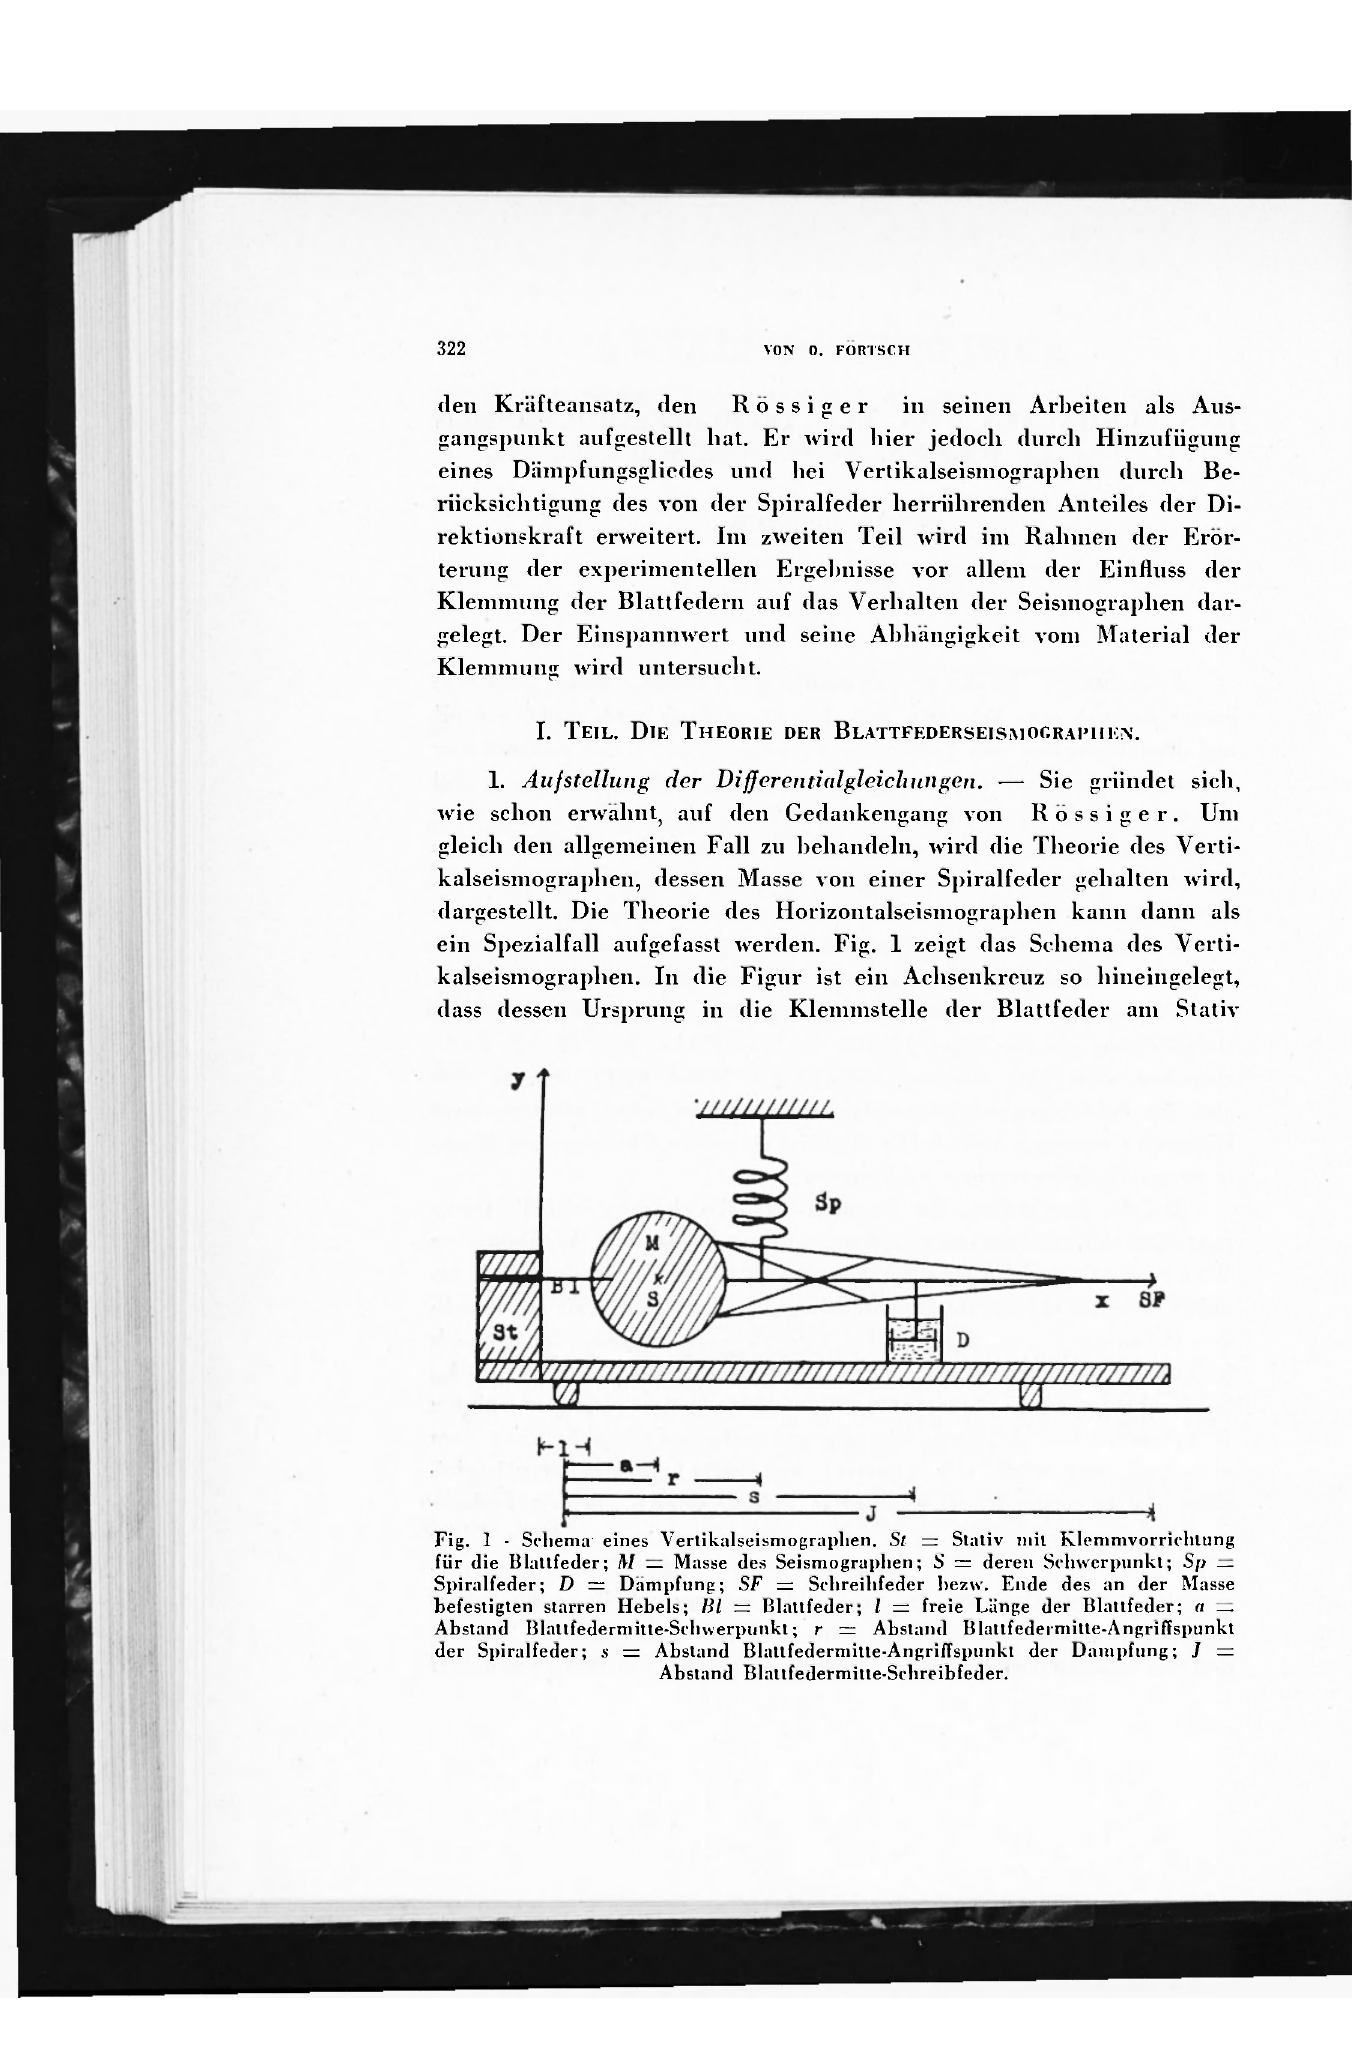
Fig. 1 - Schema eines Vertikalseismographen. St = Stativ mil Klemmvorrichlung fiir die Blattfeder; M — Masse des Seismographen; S = deren Schwerpunkt; Sp — Spiralfeder; D = Dampfung; SF = Schreihfeder hezw. Elide des an der Masse befestigten starren Hebels; HI = Blattfeder; 1 = freie Liinge der Blattfeder; a — Abstand Blattfedermitte-Schwerpunkt; r = Abstaiul Blattfedermitte-Angriffspunkt der Spiralfeder; s = Abstand Blattfedermitte-AngrifTspunkt der Dampfung; ] = Abstand